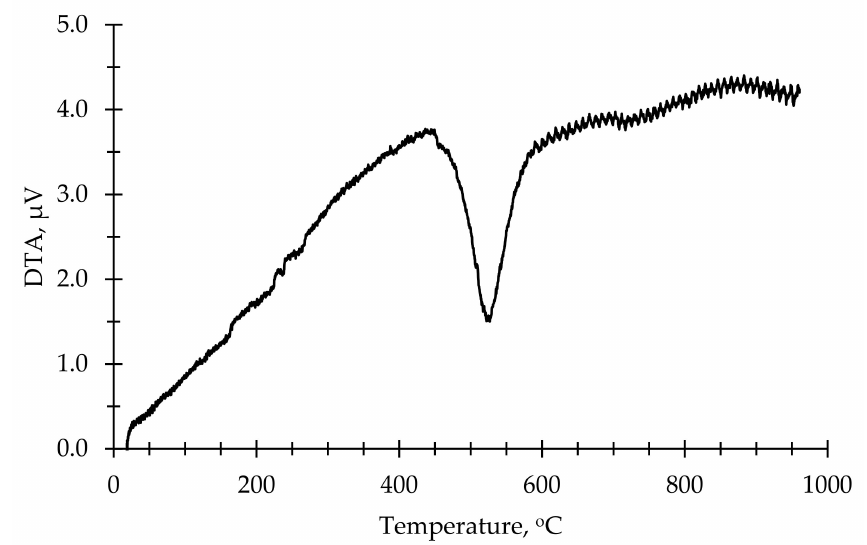
Figure 1. DTA thermogram of